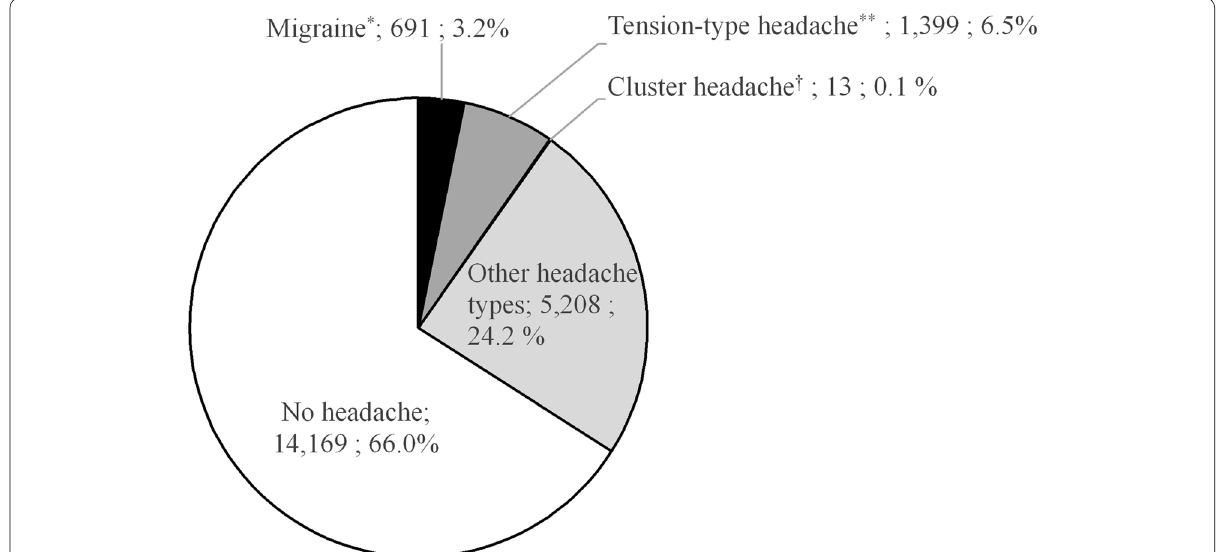
Fig. 3 Prevalence of headaches. * The prevalence of migraine (including probable migraine) is as shown in the figure above. ** The prevalence of tension-type headache (including probable tension-type headache) was 6.7% (1441 patients), including concomitant probable migraine (3 patients), concomitant migraine (3 patients), and probable migraine (36 patients). † The prevalence of cluster headache was 0.1% (21 patients), including concomitant migraine (2 patients) and probable migraine (6